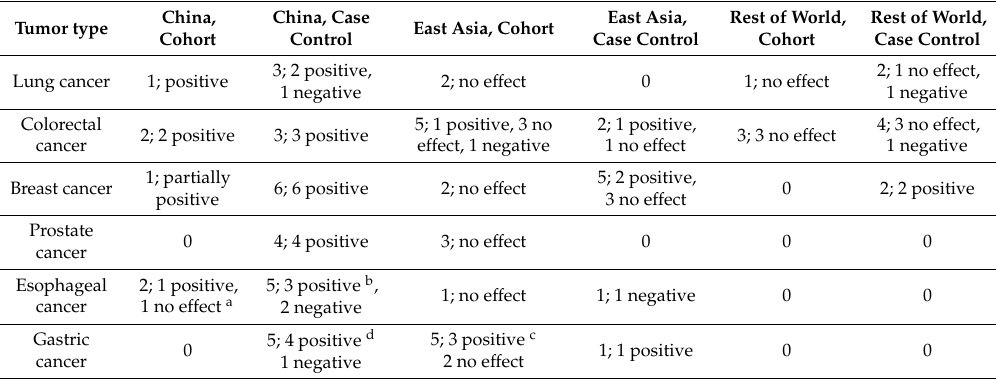
Table 10. Summary of studies and principal outcome, by country of